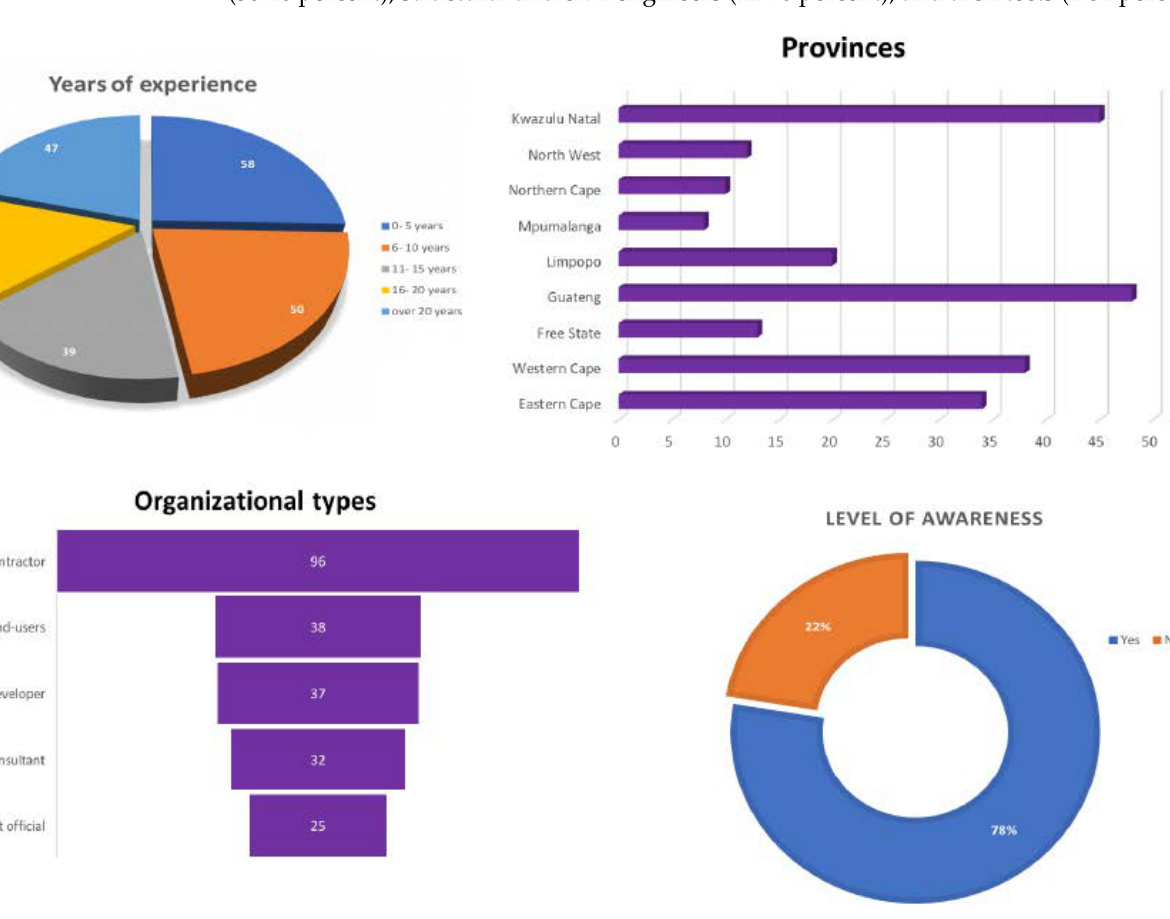
Figure 2. Demographic information of the